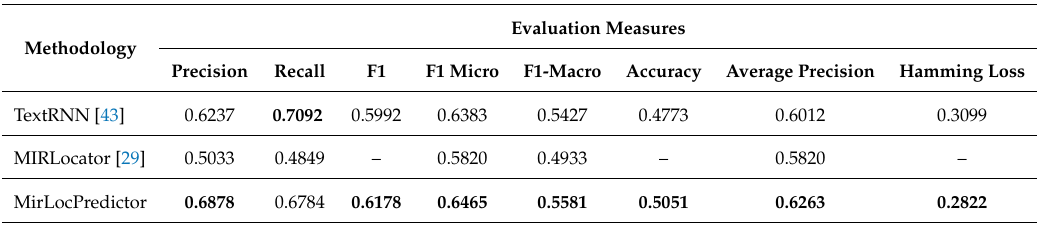
Table 3. Performance comparison of the proposed MirLocPredictor with both the state-of-the-art MIRLocator [29] and adapted TextRNN [43]